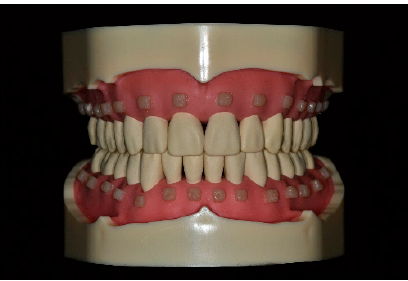
Figure 2. Modified dentiform (reference model) used in the study.